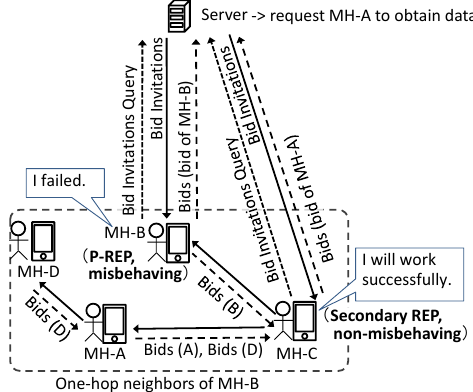
Figure 12. S-REP sending a bid invitation and receiving bids.